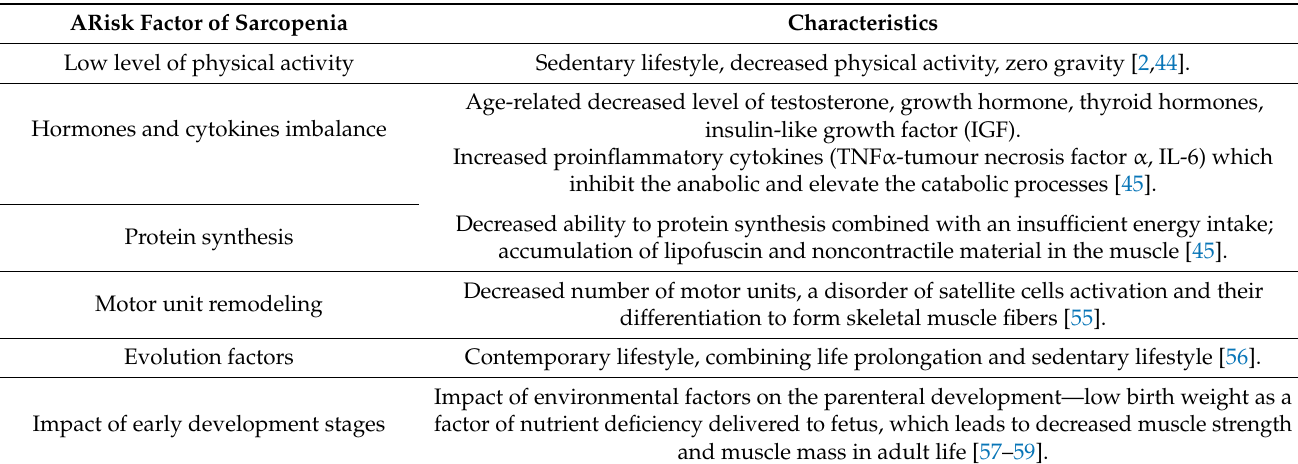
Table 2. Risk factor characteristics of sarcopenia in patients suffering from IBD.